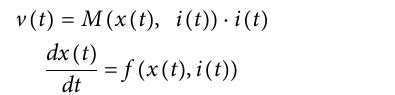
TABLE 1 | Comparisons of some reported window function in memristor models. Function Strukov